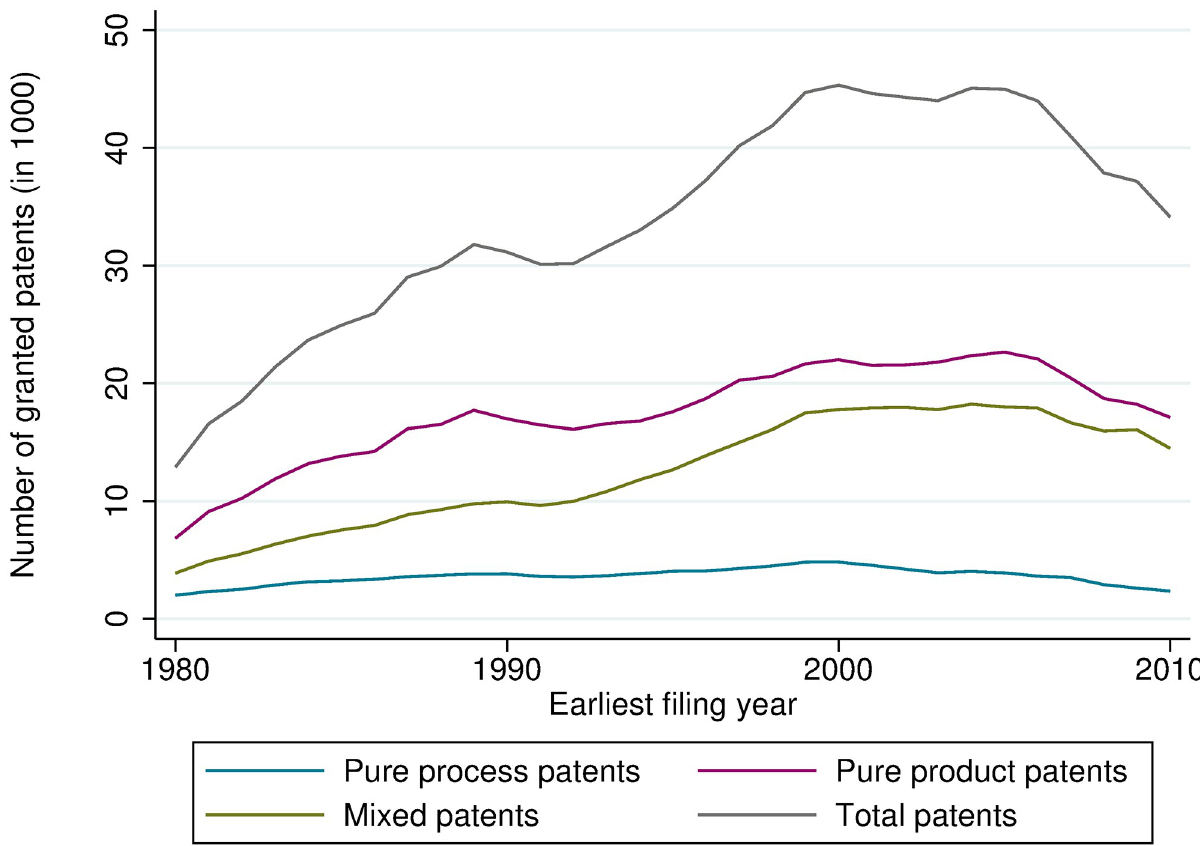
Fig 1. Count of product, process, and mixed patents, granted at the